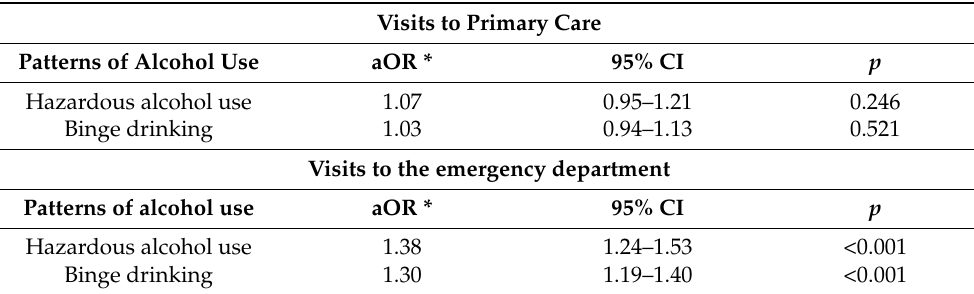
Table 5. Association between the patterns of alcohol consumption and use of health services: logistic regression